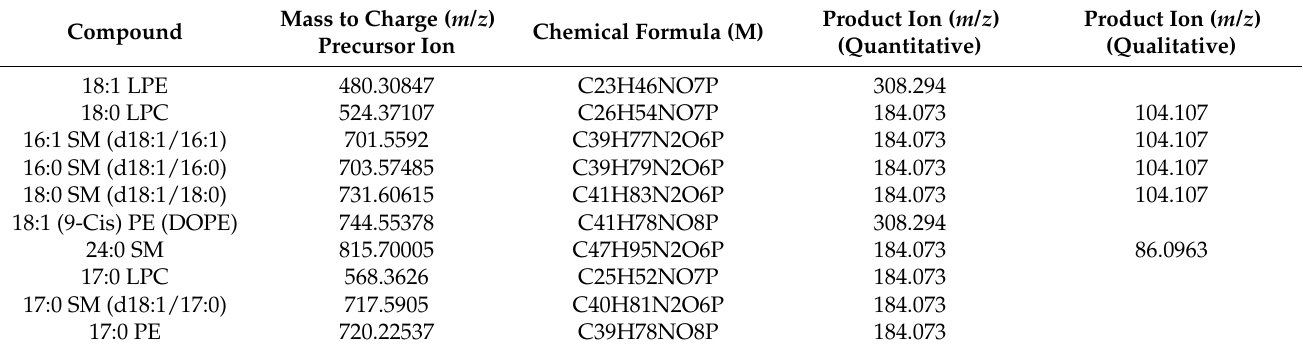
Table 1. Acquisition parameters for targeted lipid